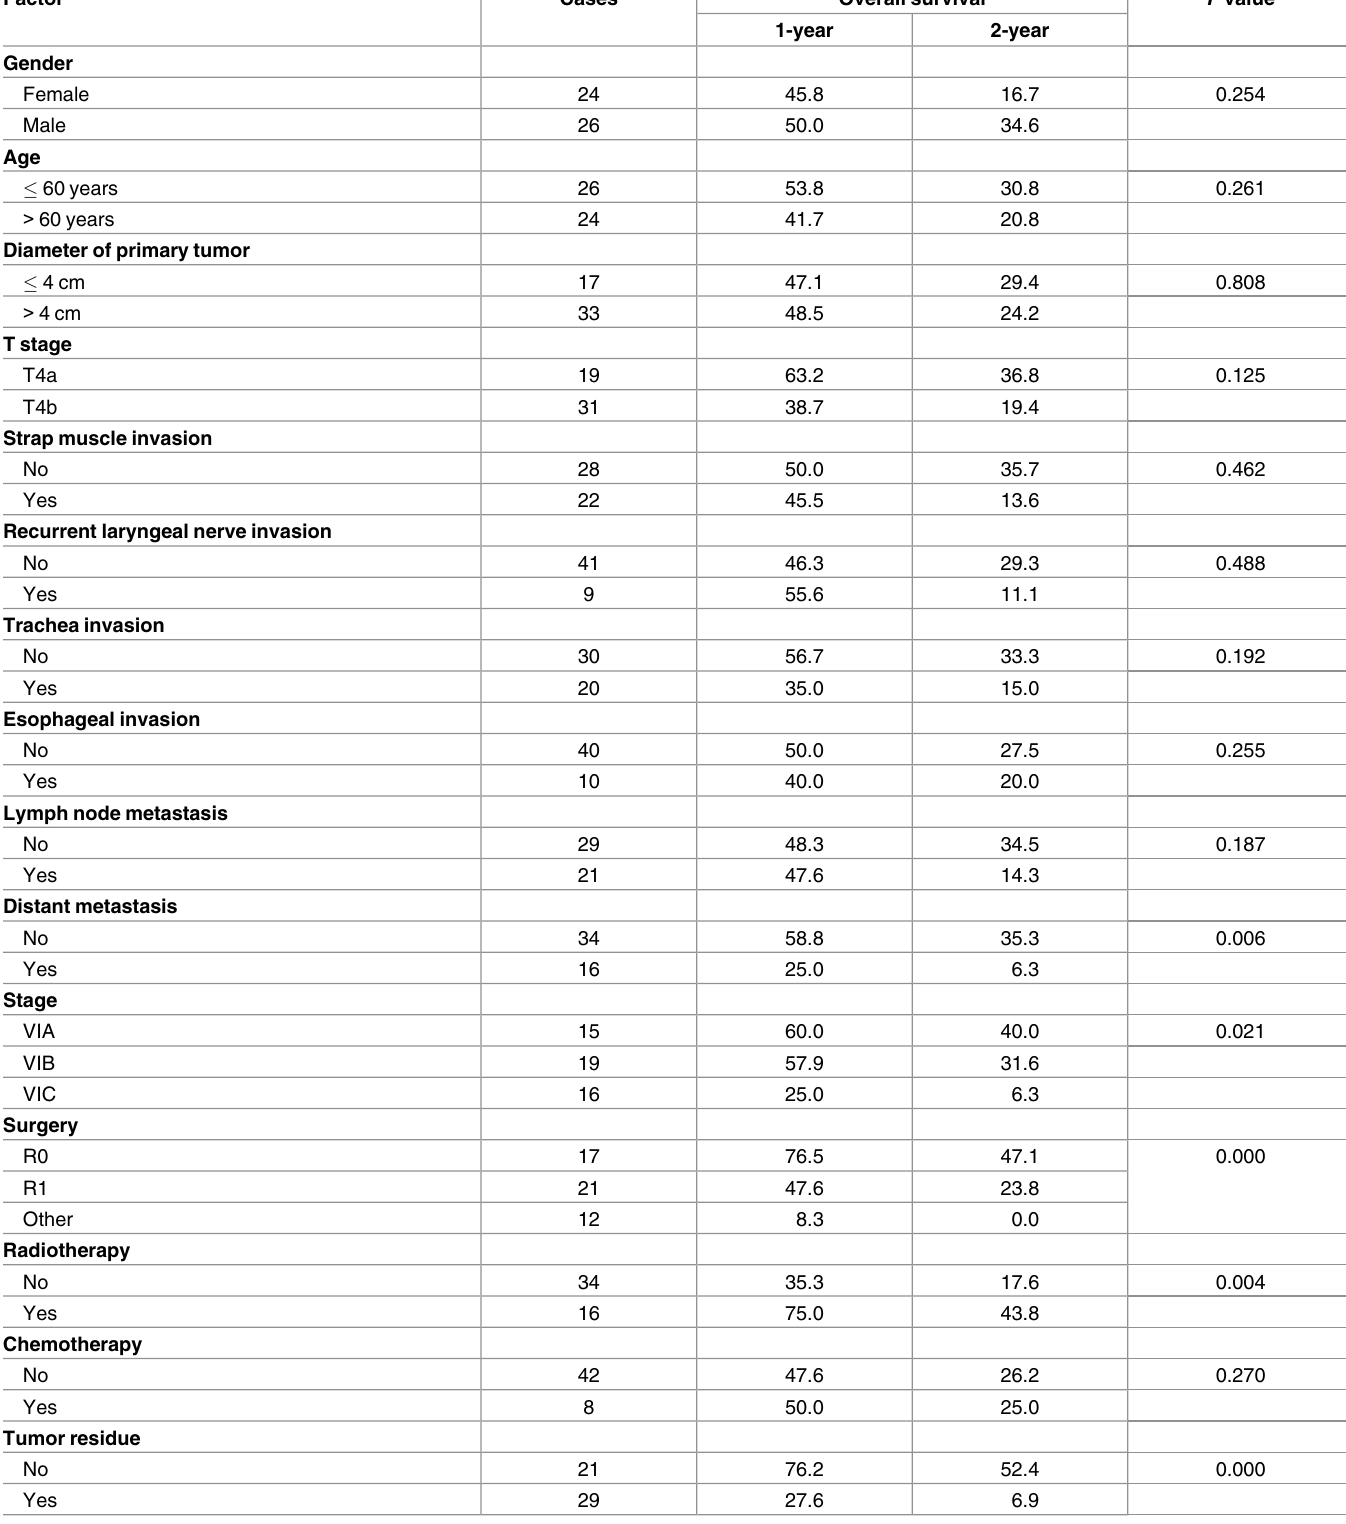
Table 1. Clinical characteristics of the 50 ATC